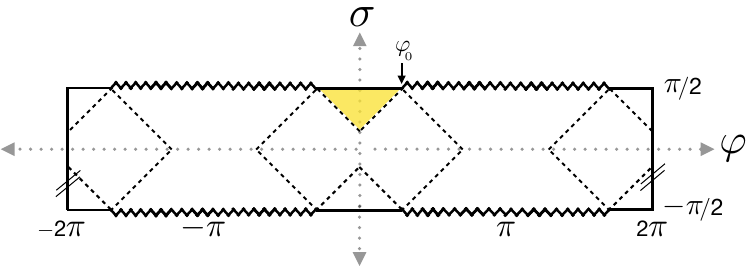
Figure 1 . Penrose diagram for dS n with n = 2 . An expanding patch is shaded in yellow, and it 2 intersects I + on the interval ( − ϕ 0 , ϕ 0 ) where ϕ 0 < π/ 2